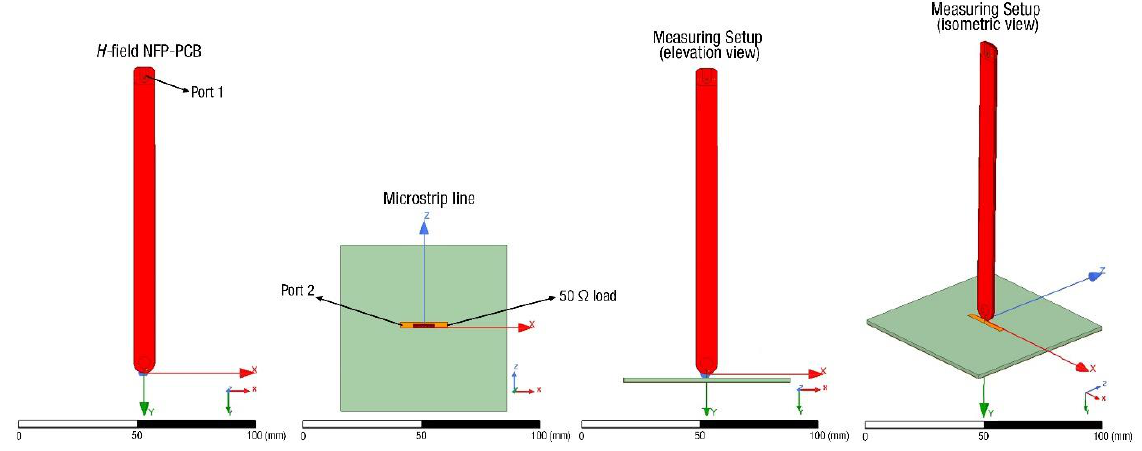
Figure 6. Simulation model designed to obtain the S-parameters of the NFP